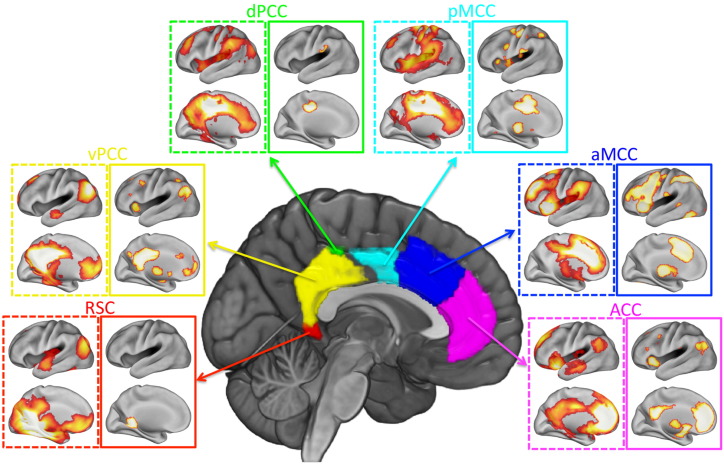
Comparison between resting state and MACM connectivity fingerprints. For each cluster, resting state (left, dashed line box) and MACM (right, solid line box) connectivity maps are shown side-by-side. Both resting state and MACM maps were corrected for multiple comparisons (FWE, p < 0.05). Only the left hemisphere is presented for each modality, however the left and right hemisphere showed highly similar connectivity patterns. The colour code for boxes corresponds to the colour code established in Fig. 2.